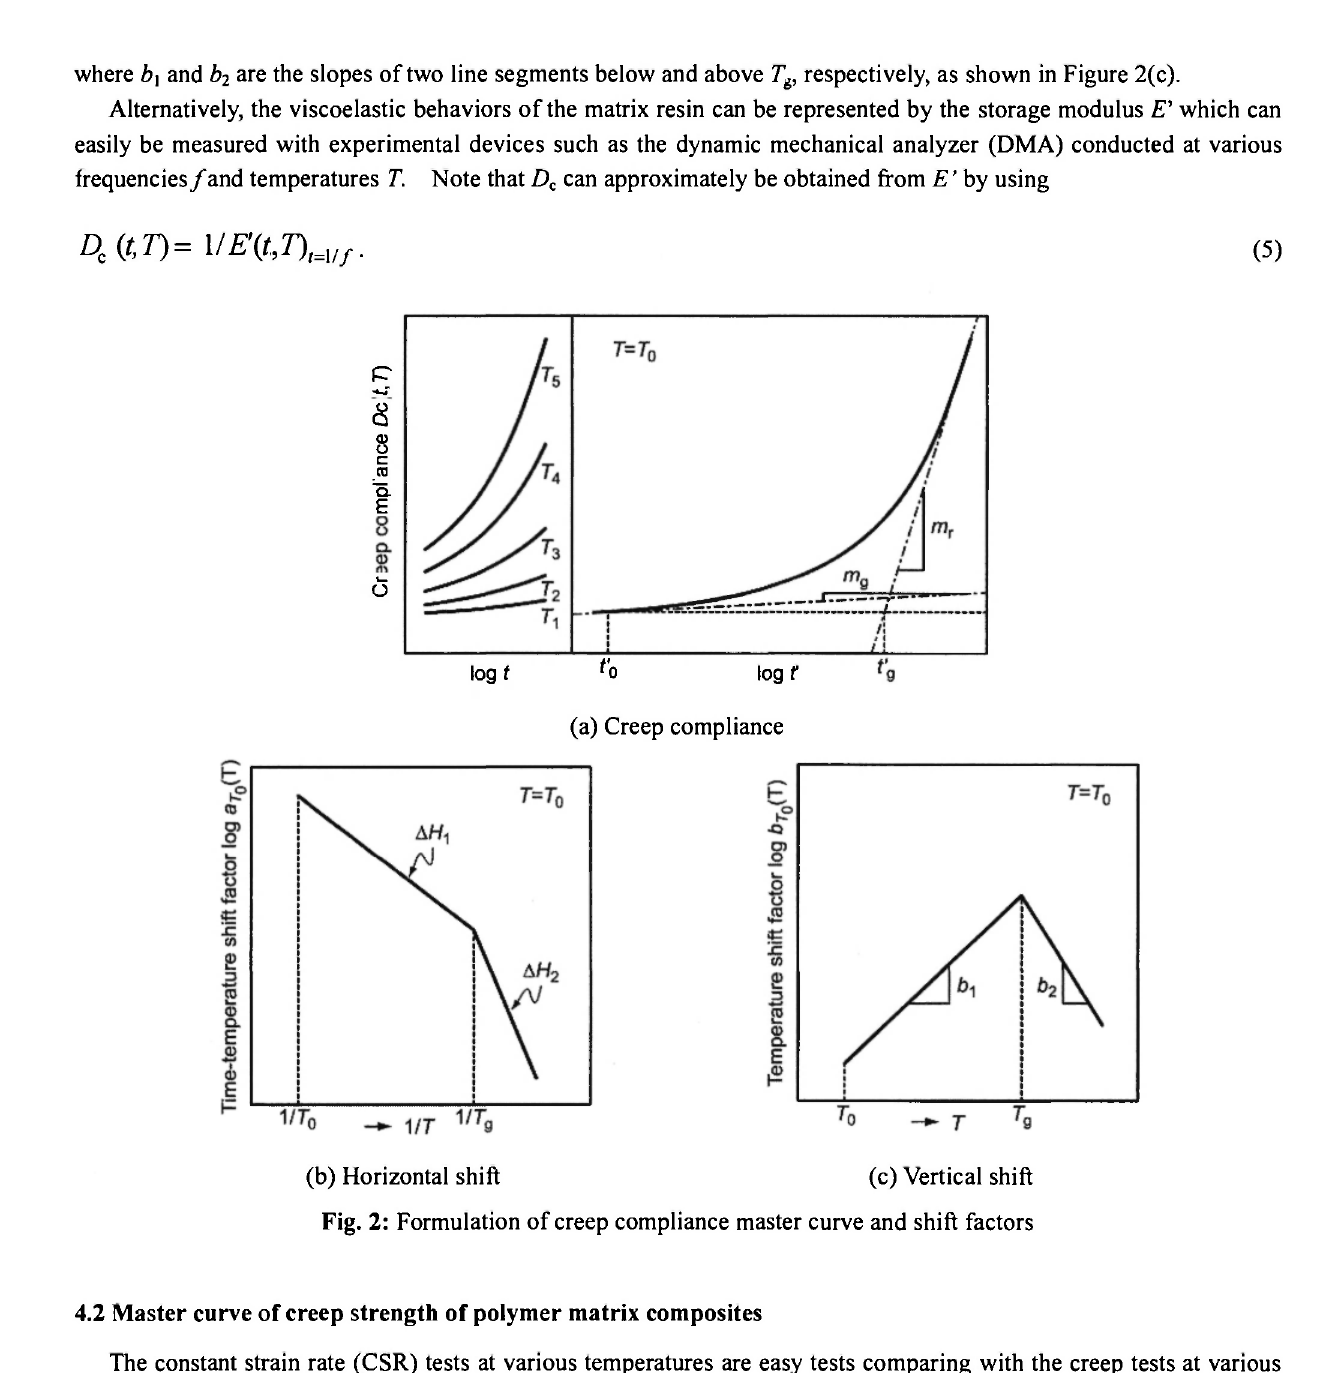
Fig. 2: Formulation of creep compliance master curve and shift